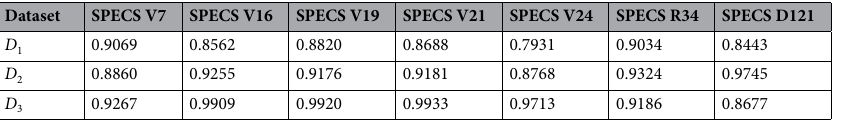
Table 9. AUC values obtained by classifiers on test samples in different